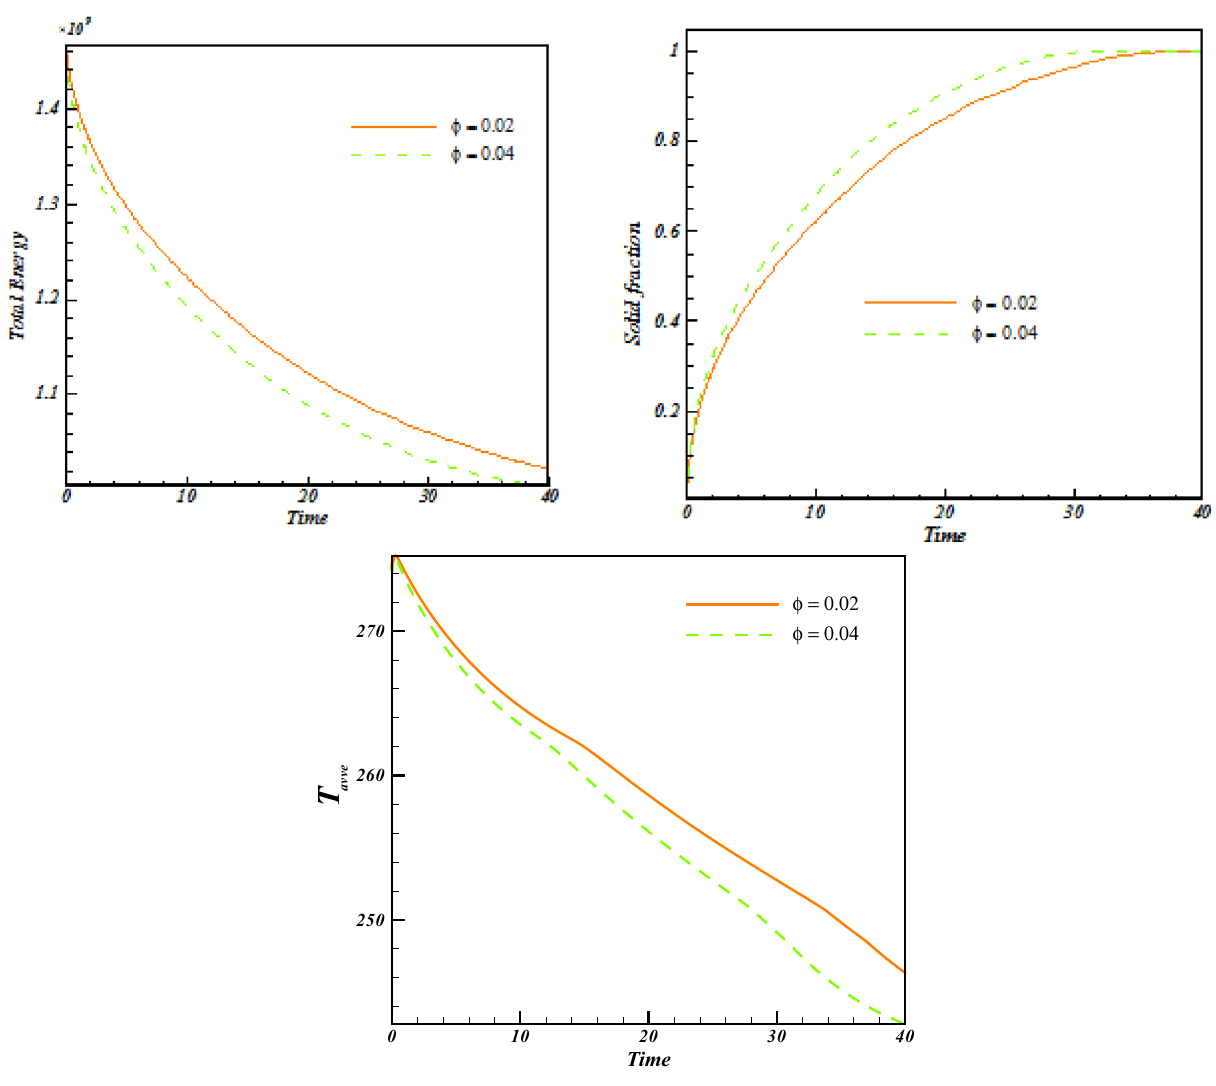
Figure 7. Progress of time change of parameters with later of ϕ.